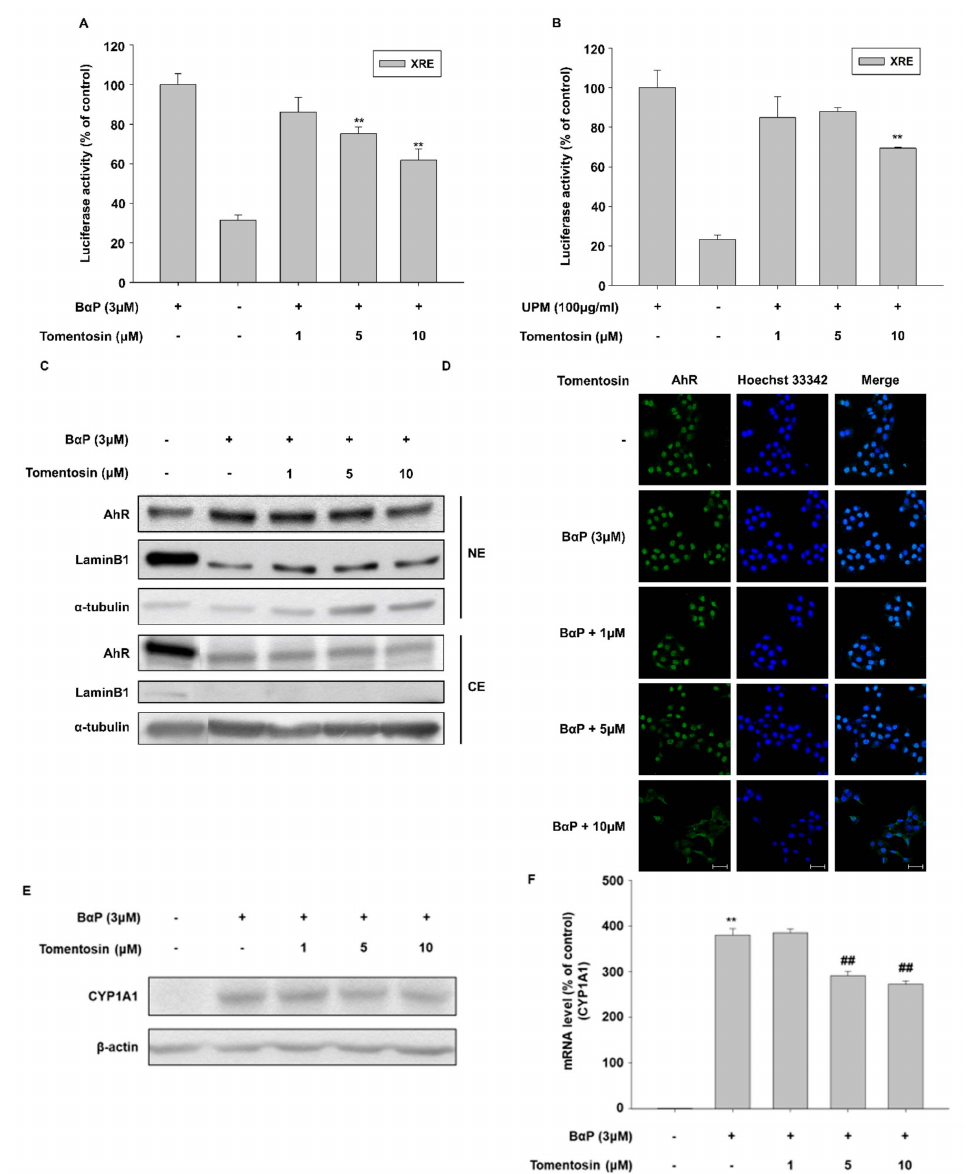
Figure 5. Tomentosin suppresses aryl hydrocarbon receptor (AhR) signaling activated by